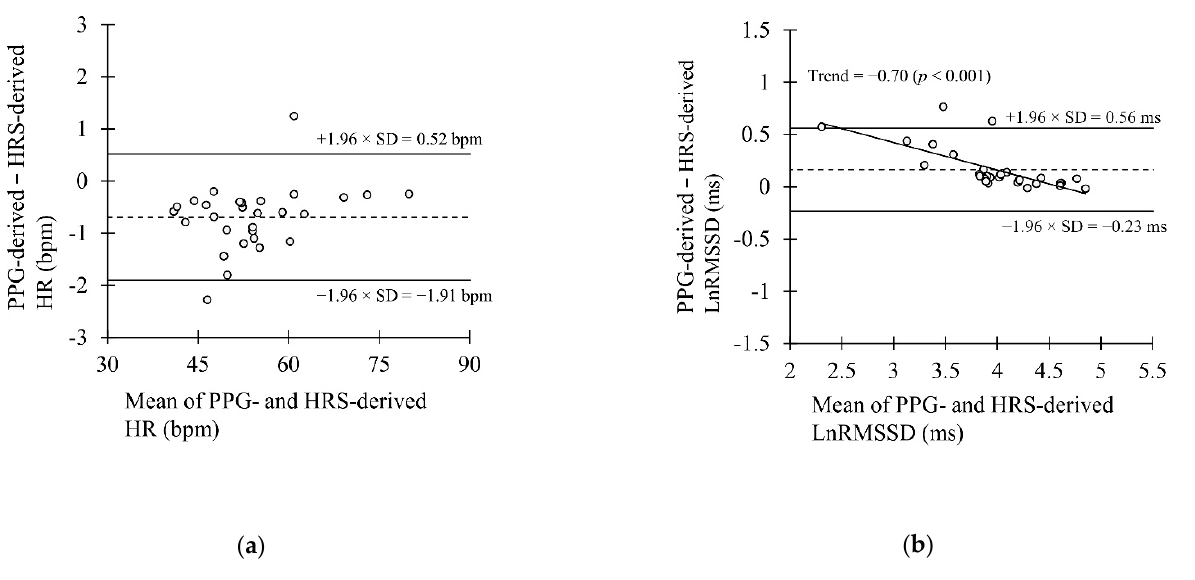
Figure 6. Bland-Altman plot presenting the mean bias and the limits of agreement in the laboratory recordings in the ( a ) nocturnal HR recordings and ( b ) nocturnal LnRMSSD recordings.